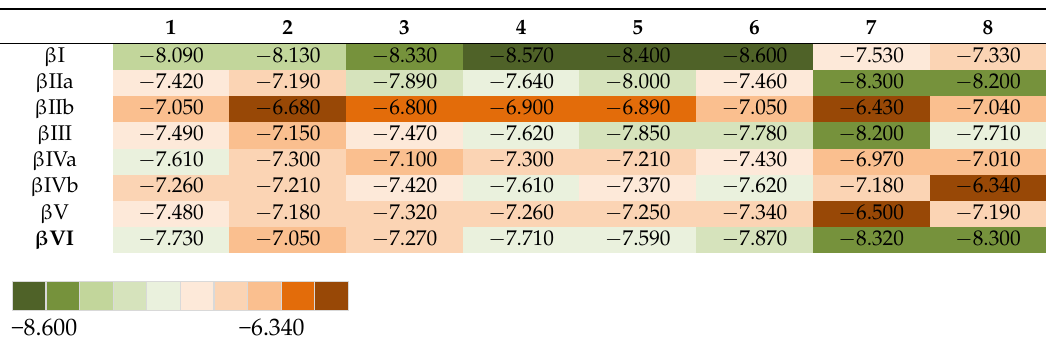
Table 3. Heat map of binding energies interactions between the eight different colchicine derivatives and βІ, βIII βІIa, βІIb, βIVa, βIVb, βV and βVI tubulin